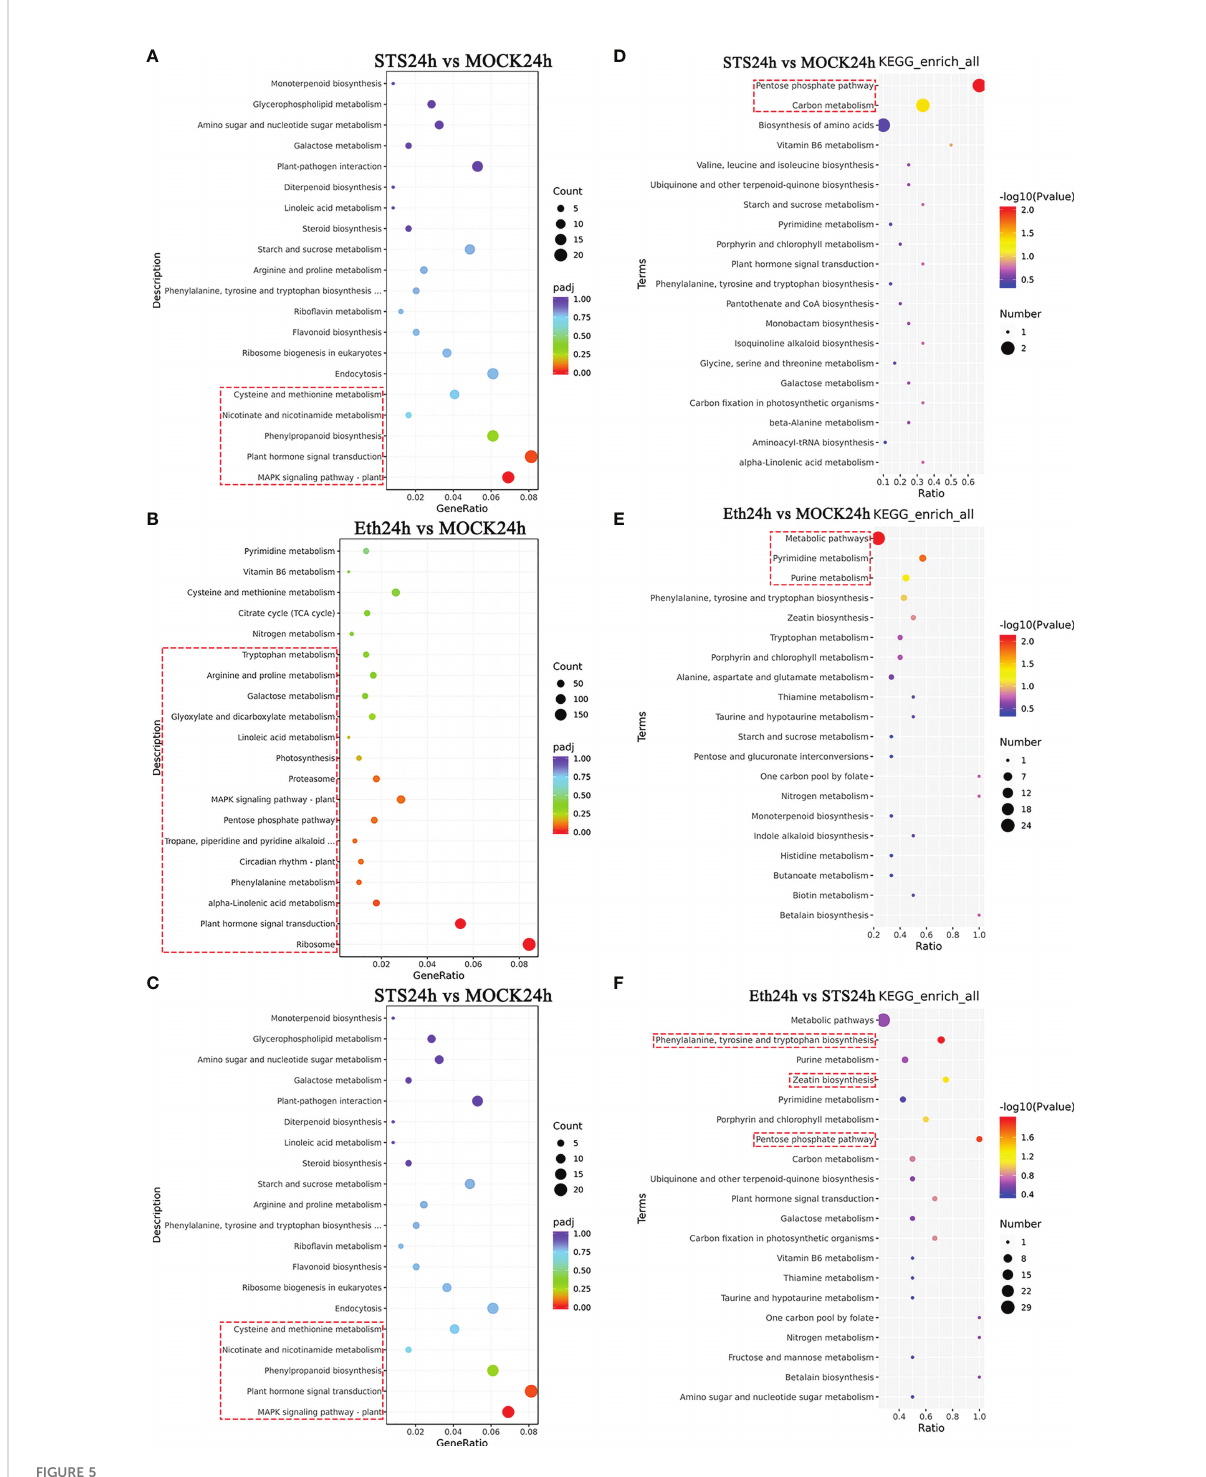
FIGURE 5 KEGG enrichment analysis of DAMs and DEGs. (A – C) KEGG enrichment analysis of 50 DAMs. (D – F) KEGG enrichment analysis of DEGs. The red dashed boxes indicated the KEGG pathways that were signi fi cantly enriched (p-value <